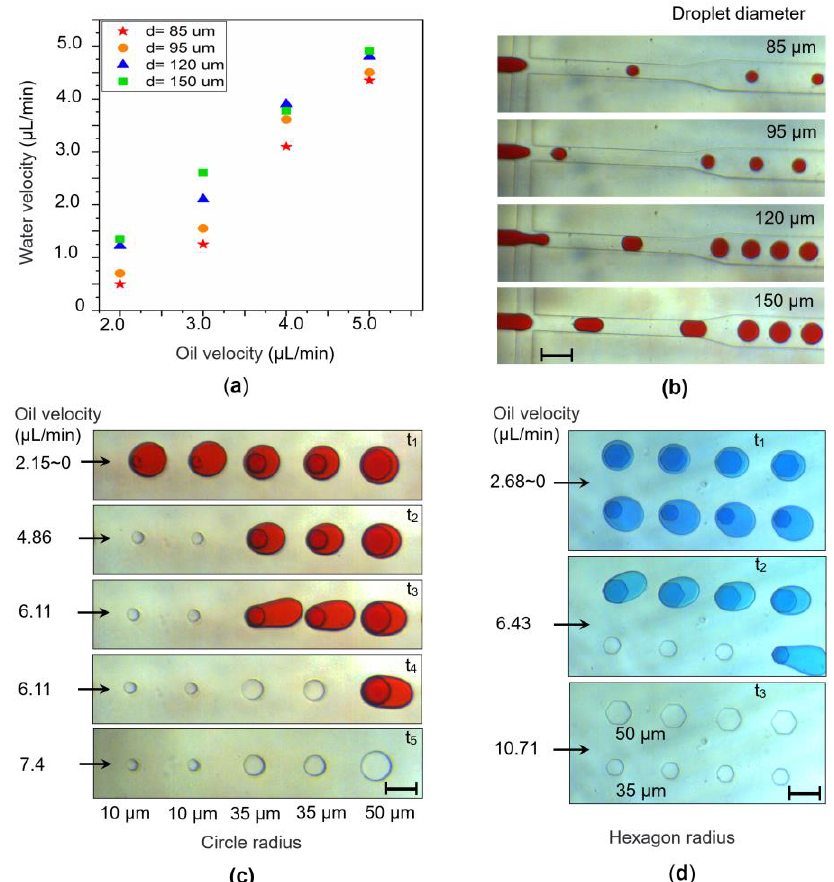
Figure 2. ( a ) The droplet diameter can be kept constant by changing the flow rates of the two phases simultaneously within a certain range, an important prerequisite for the dual-inlet design of the chip. ( b ) High-speed microscopy images of droplets with specific diameters generated by applying varying oil and liquid (red ink) flow rate combinations . Scale bars: 200 μm . ( c ) Circular SEW test: droplets of equal size are pre-trapped by the circular SEWs at a low oil flow rate (t 1 ). As the oil flow rate gradually increases (t 2 ~t 5 ), the trapped droplets are sequentially released, starting from the smallest SEW (10 μm radius) , and finally from the largest SEW (50 μm radius). Scale bars: 100 μm . ( d ) The same test was performed using hexagonal SEWs of varying sizes. It was clear that the critical SEWs . Scale bars: 100 μm